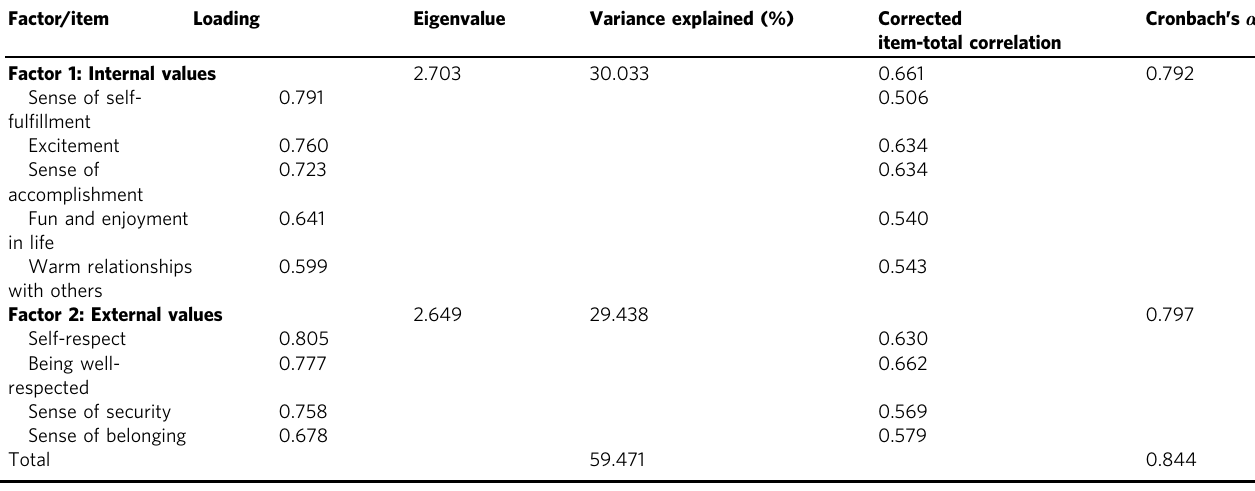
Table 3 EFA of personal values.